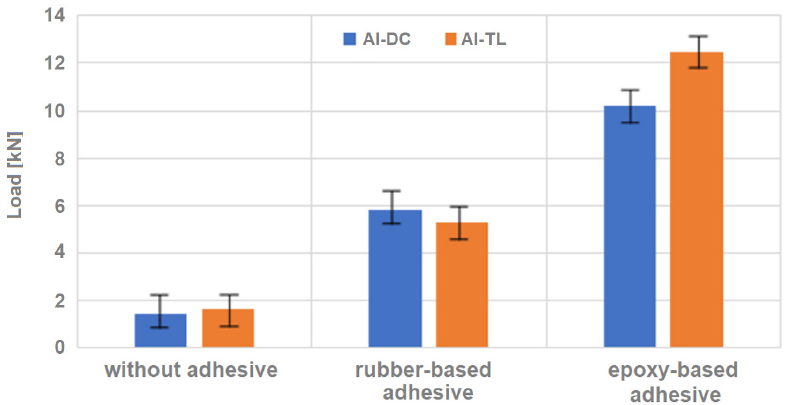
Figure 19. Tensile shear test results of Al-DC and AL-TL samples without adhesive and with two types of adhesives.